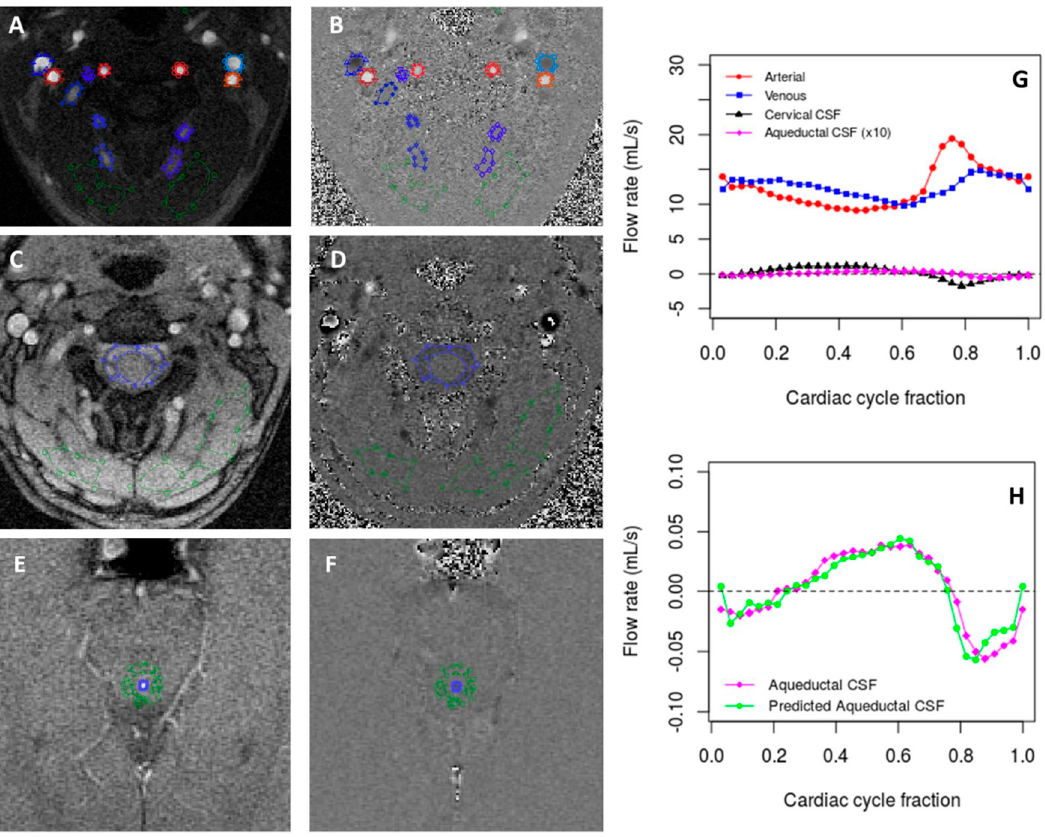
Figure 2. Phase contrast images and flow quantification of subject 5005 (exemplificative typical case). Magnitude ( A , C , E ) and phase ( B , D , F ) images of the phase contrast sequence for the acquisition of neck blood flow (A, B), cCSF (C, D), aCSF (E, F). Arterial, venous, cCSF and aCSF flow rate curves ( G ). (N.B. the venous signal has been inverted for comparison purposes). Actual and predicted aCSF flow rate curves ( H ). The aCSF flow was predicted from the arterial, venous and cCSF flow rates with an r 2 = 0.884.